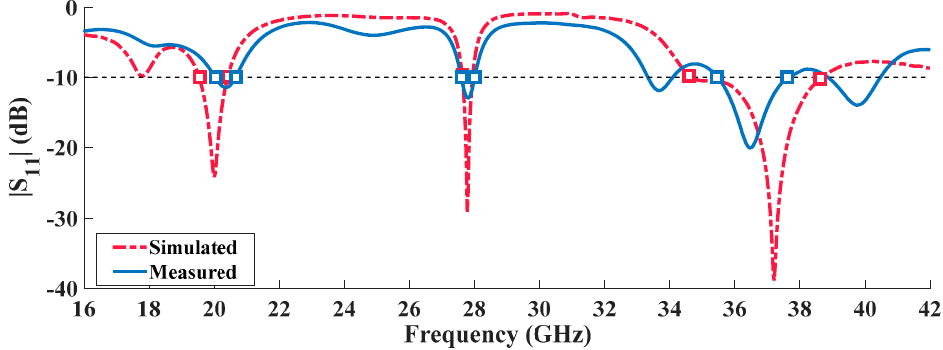
Figure 8. Simulated and Measured Reflection Coefficient of the Tri-Band Antenna.